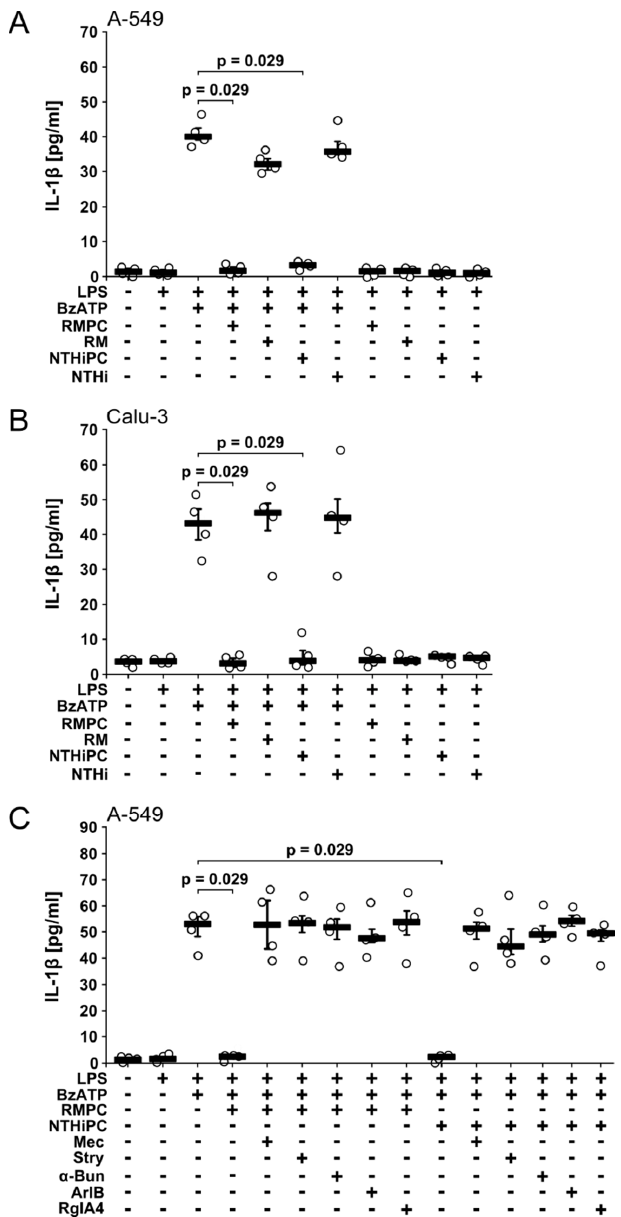
Figure 3. Phosphocholine-modified lipooligosaccharides (PC-LOS) isolated from H. influenzae strains inhibit the release of IL-1 β by A549 and Calu-3 cells. Human LPS-primed A549 ( A , C ) or Calu-3 ( B ) cells were stimulated with BzATP (100 µM) in the presence or absence of PC-LOS isolated from the H. influenzae strains RM118 (RMPC; 1 µg/mL) and NTHi 1233 (NTHiPC; 1 µg/mL) and IL-1 β released to the supernatant was measured after 30 min. PC-free LOS from the corresponding lic1 -mutant strains RM7004- lic1 (RM; 1 µg/mL) and NTHi1233- lic1 (NTHi; 1 µg/mL) lacking the PC-modification were included as a negative control. ( C ) The inhibitory effects of RMPC and NTHiPC were reversed by nicotinic antagonists mecamylamine (Mec; 100 µM)), strychnine (Stry; 10 µM), α -bungarotoxin ( α -Bun; 1 µM), [V11L, V16D]ArIB (500 nM), or RgIA4 (200 nM). Data are presented as individual data points, bars represent median, whiskers encompass the 25th to 75th percentile, n = 4 per experiment. Experimental groups were compared by Kruskal Wallis test followed by Mann Whitney rank sum test.